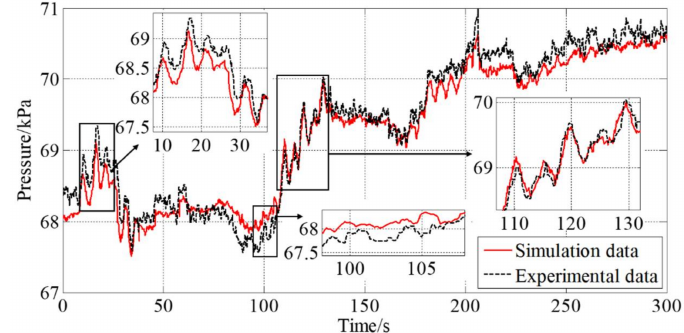
Figure 19. Comparison of pressure changes in cross Section 1.